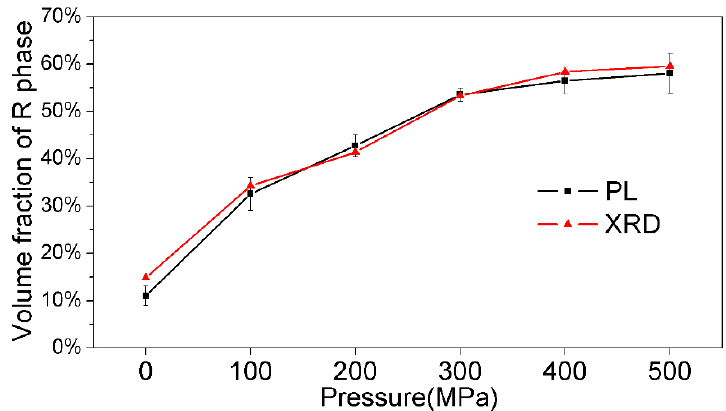
Figure 6. Variations of the fraction of the R phase of the NKBET20 ceramic powders under various pressures.